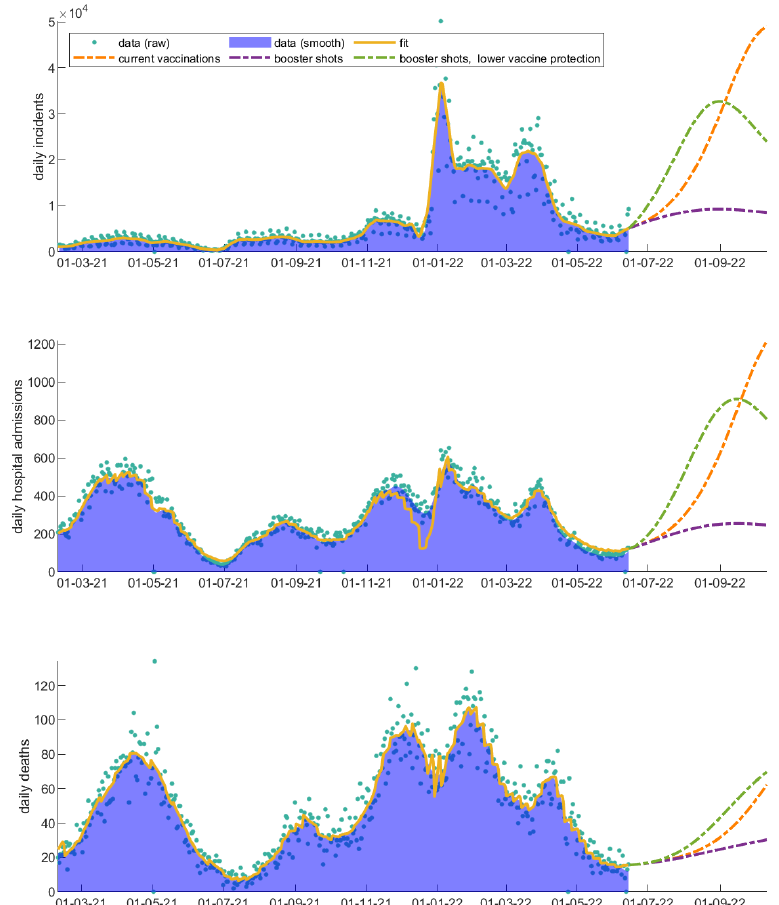
Figure 10. The impact of an e ff ective booster shot is shown under the dominance of omicron sub ‐ variants. The fi tt ing time period is 1 February 2021–15 June 2022. The daily (a) incidents, (b) hospital admissions, and (c) deaths are shown. admissions, and (c) deaths are